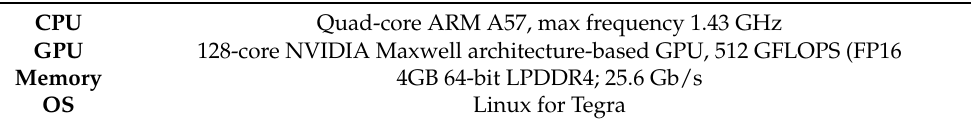
Table 5. The main characteristic of NVIDIA Jetson nano device.